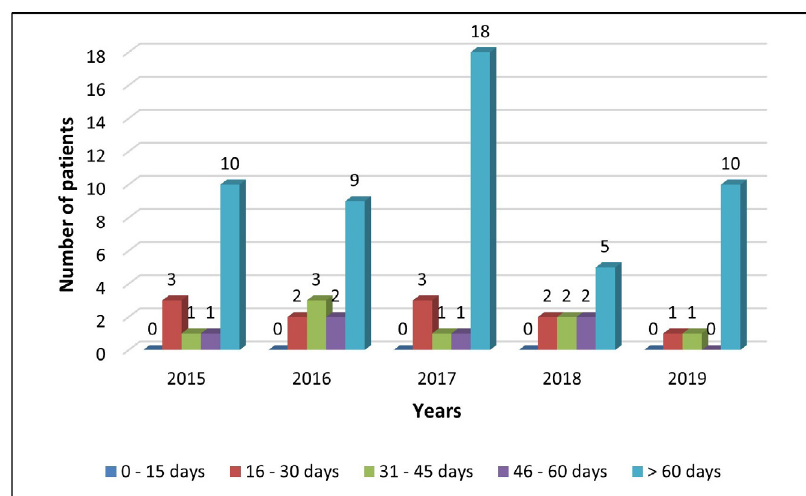
Figure 8. Age of onset of treatment for infants diagnosed with